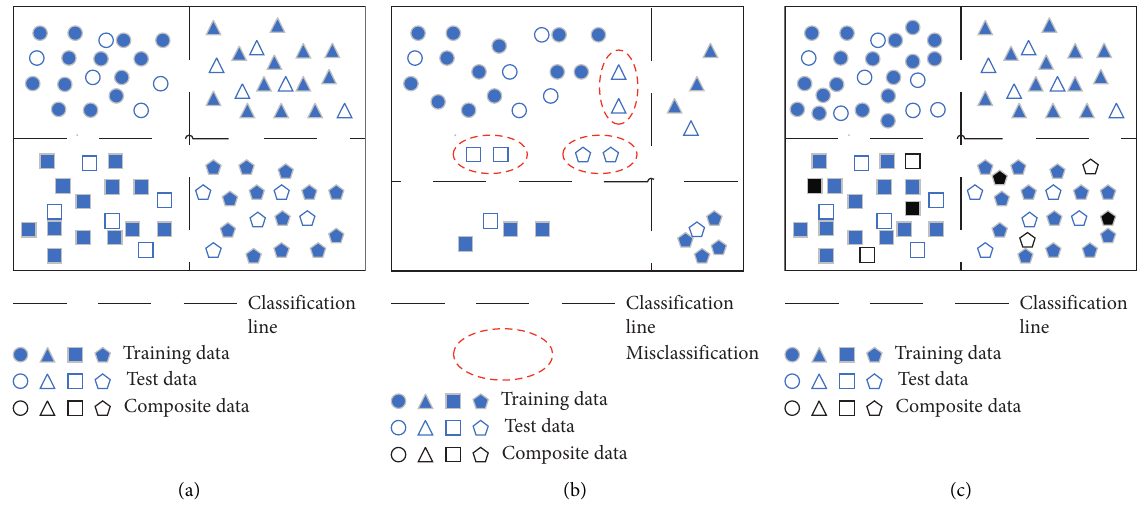
Figure 1: Classification of balanced data using synthetic data. (a) Balanced data, (b) unbalanced data, and (c) composite